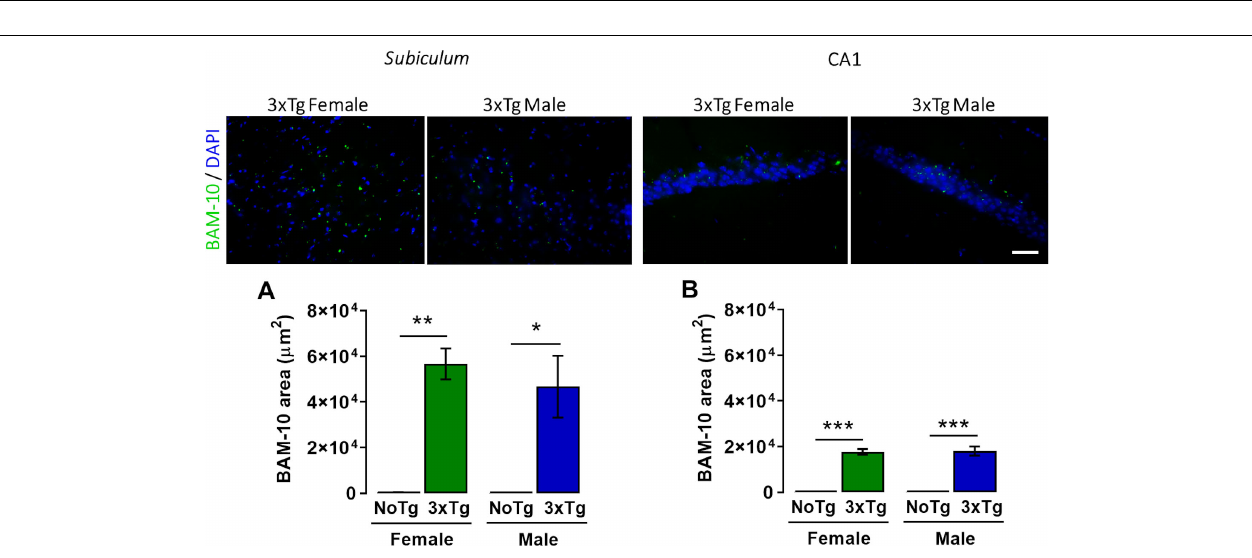
FIGURE 4 | Representative images of β -amyloid (green) immunohistochemistry and nuclei detection (blue) obtained with 40 × objective in the subiculum and CA1 of the dorsal hippocampus of female and male 3xTg-AD at 5 months old. Mean BAM-10 area ( µ m 2 ) (with standard error) of female and male non-transgenic (NoTg) or Alzheimer’s disease triple-transgenic (3xTg-AD) mice in the (A) subiculum and (B) CA1. * p < 0.05, ** p < 0.001, *** p < 0.0001; n = 4 mice per group. Scale bar = 20 µ m.